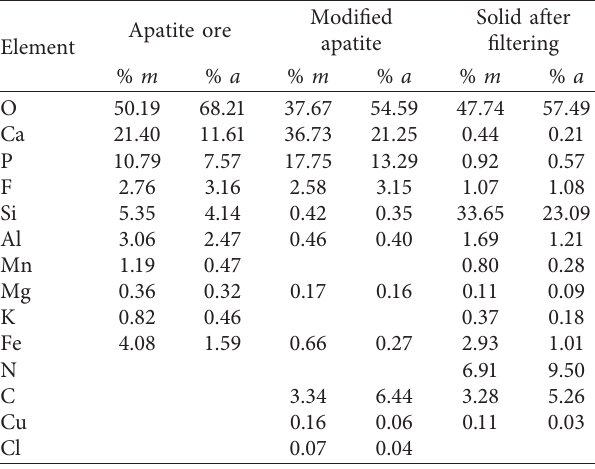
Figure 5: EDX spectra of apatite ore before and after modifying and the solid after filtering. (a) Apatite ore. (b) Modified apatite. (c) Solid after filtering. Table 1: Composition of elements in apatite ore before and after modifying and the solid after